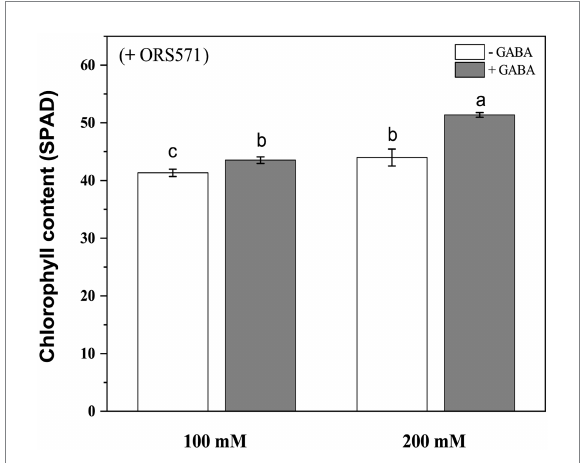
FIGURE 7 Chlorophyll content of Sesbania rostrata inoculated with ORS571 under NaCl stress with or without GABA. The chlorophyll content of GABA treatment was significantly higher than that of the control under salt stress. Different lower-case letters in each column shape indicate significant difference at p < 0.05 by statistical analysis. Error bars indicate standard deviations from four parallel replicates.